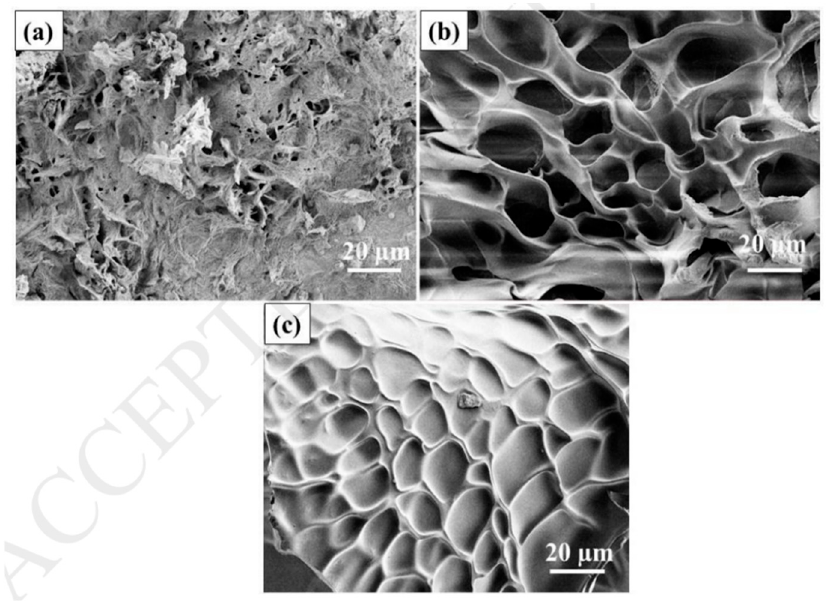
Figure 8. ( a ) CMC hydrogel, ( b ) CMC/PAM composite hydrogel, and ( c ) CMC/PAM composite hydrogel after the adsorption of Cu 2+ . (Reprinted from Ref. [92], Copyright (2022), with permission from Elsevier).